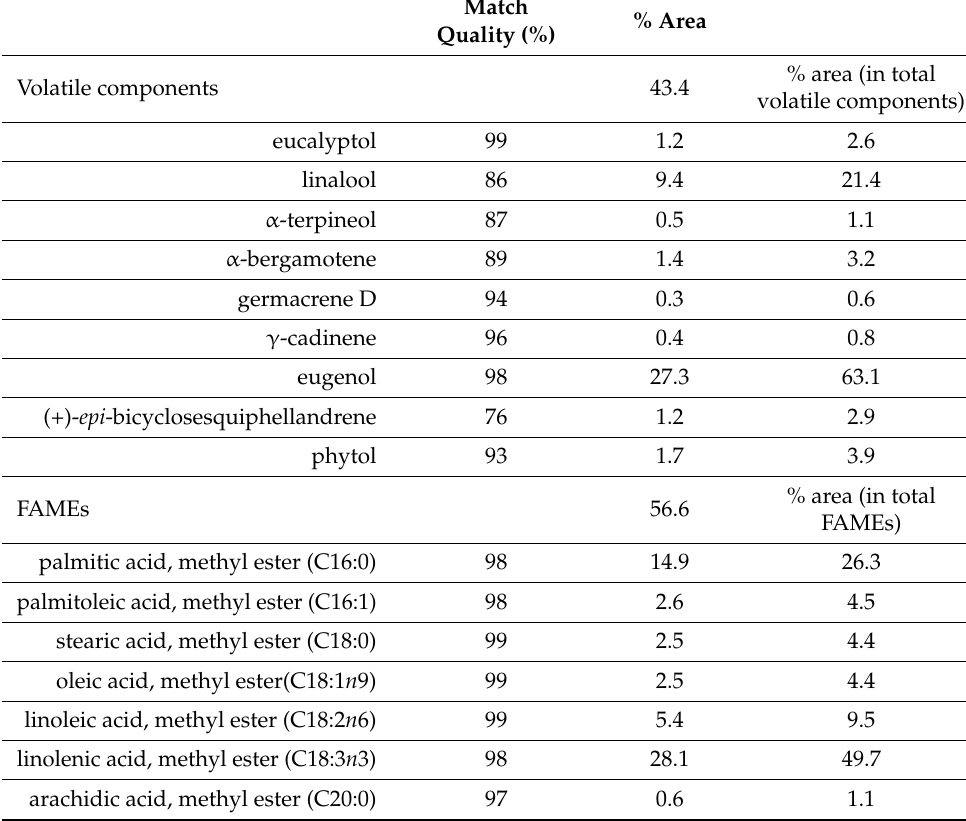
Table 2. Compounds detected by the GC-MS analysis of a transmethylated basil leaves extract sam- ple.